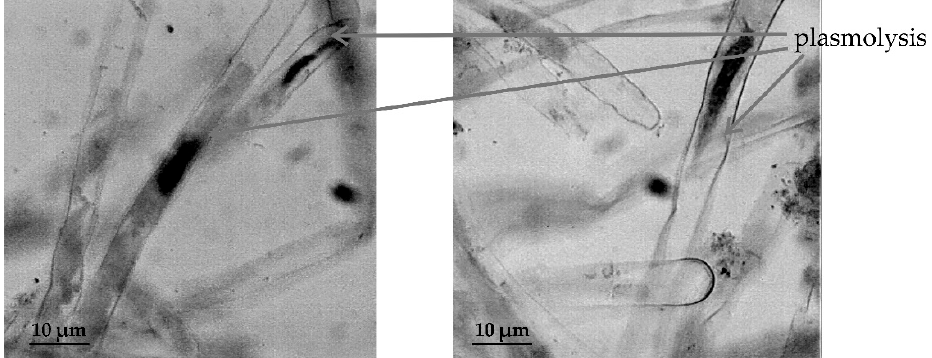
17.6%, 72 h), scale bar = 10 µm.